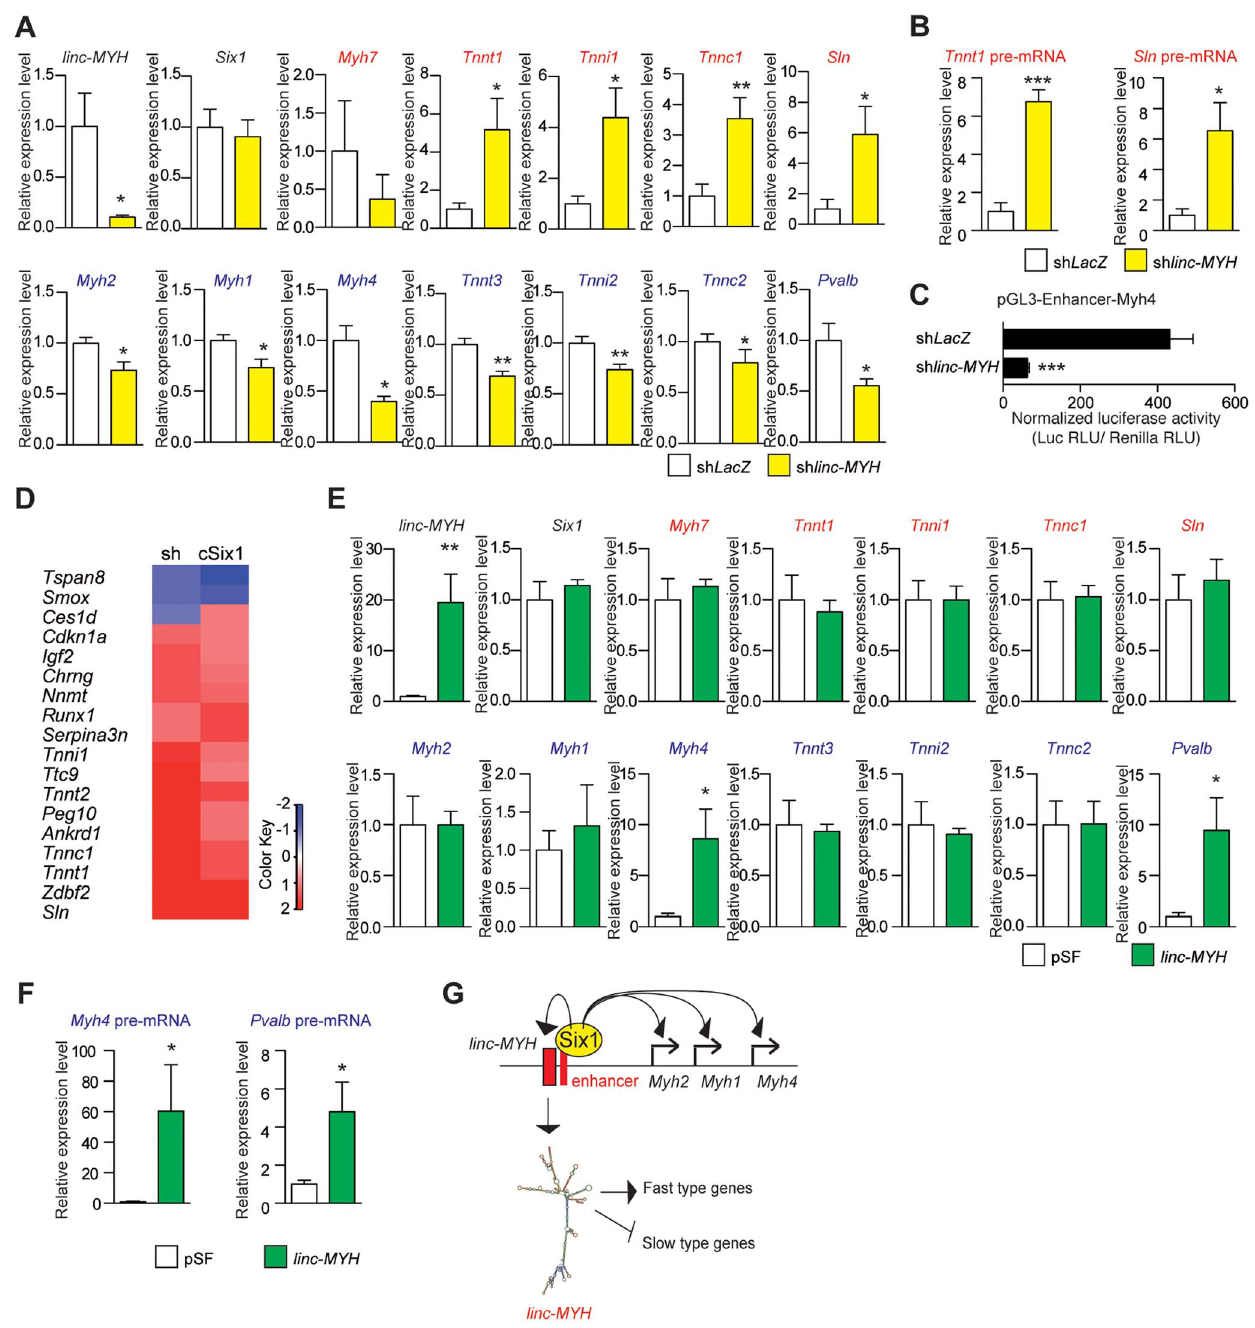
Figure 5. Slow-type gene expression is suppressed by linc-MYH . (A) qPCR experiments revealing mRNA expression levels of linc-MYH , Six1 , slow-type genes (red) and fast-type genes (blue) in TA muscles expressing a shRNA directed against linc-MYH or LacZ (n=5). (B) qPCR experiments revealing pre-mRNA expression of the Tnnt1 and Sln slow genes in TA muscles expressing a shRNA directed against linc-MYH or LacZ (n=5) (C) Luciferase activity of pGL3-Enhancer- Myh4 in TA muscles expressing a shRNA directed against linc-MYH or LacZ (n=4). (D) Microarray analysis of TA muscles transfected by shRNA against linc-MYH : a heat map of genes (red) upregulated to more than double the levels observed in c Six1 KO. (E) qPCR experiments revealing mRNA expression levels of linc-MYH , Six1 , slow-type genes (red) and fast-type genes (blue) in Soleus muscles expressing linc- Myh or the empty vector pSF (n=4). (F) qPCR experiments revealing pre-mRNA expression of the Myh4 and Pvalb fast genes in Soleus muscles expressing linc-Myh or the empty vector pSF (n=4) (G) A model of Six1 controlling the expression of the different MYH and of linc-MYH at the fast Myh locus in fast myofibers. Below, the hypothesis explaining the linc-MYH mode of action, as supported by the transcriptomic-wide analysis performed after linc-MYH knockdown in fast TA. *P , 0.05, **P , 0.01, ***P , 0.001.